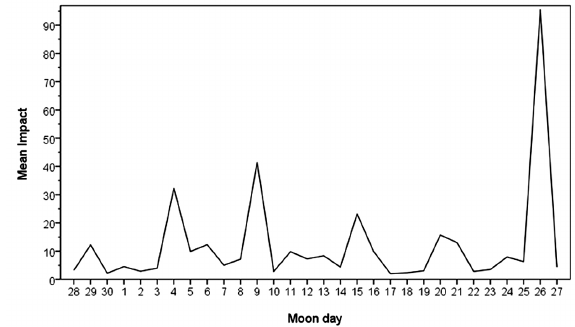
Fig. 6. – Evolution throughout a full moon cycle of the mean impact in the habitats of the node-1 habitats group (see